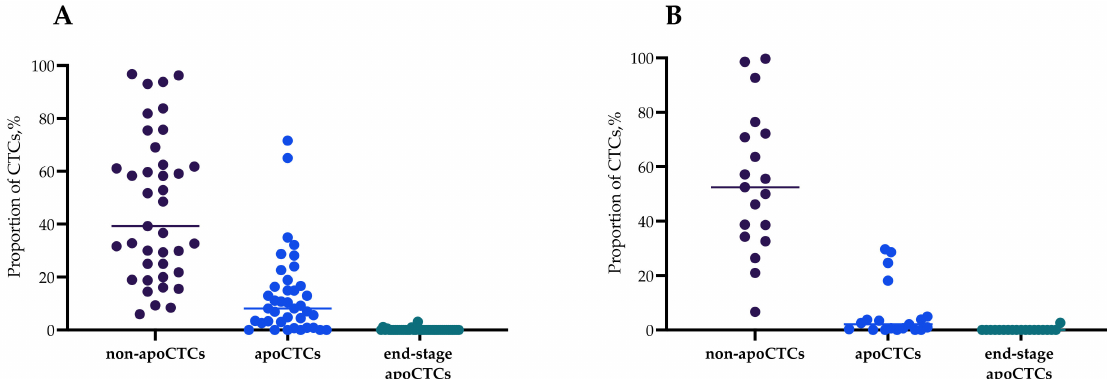
Figure 1. Percentage of non-apoCTCs, apoCTCs and end-stage apoCTCs in untreated breast can- cer patients ( A ) and breast cancer patients treated with neoadjuvant chemotherapy breast cancer patients ( B ),